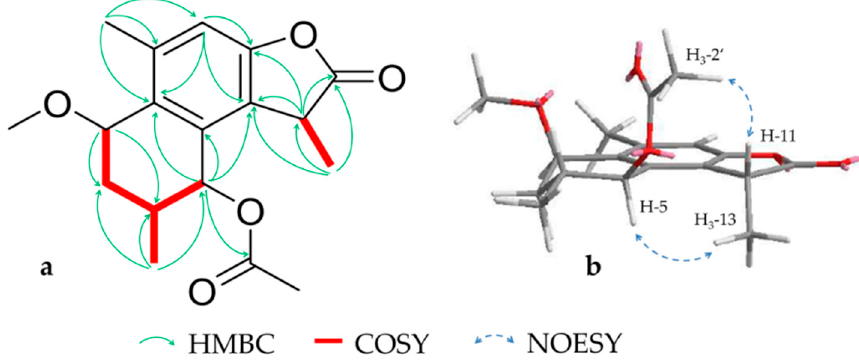
Figure 5. Key HMBC, COSY ( a ) and NOESY ( b ) correlations for compound 6 .